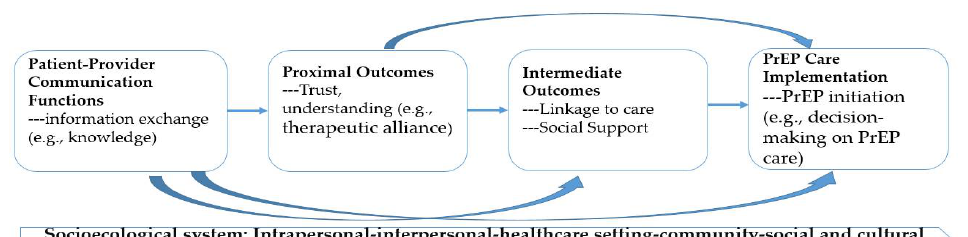
Figure 2. Integrated model of Communication Pathways on PrEP care implementation.